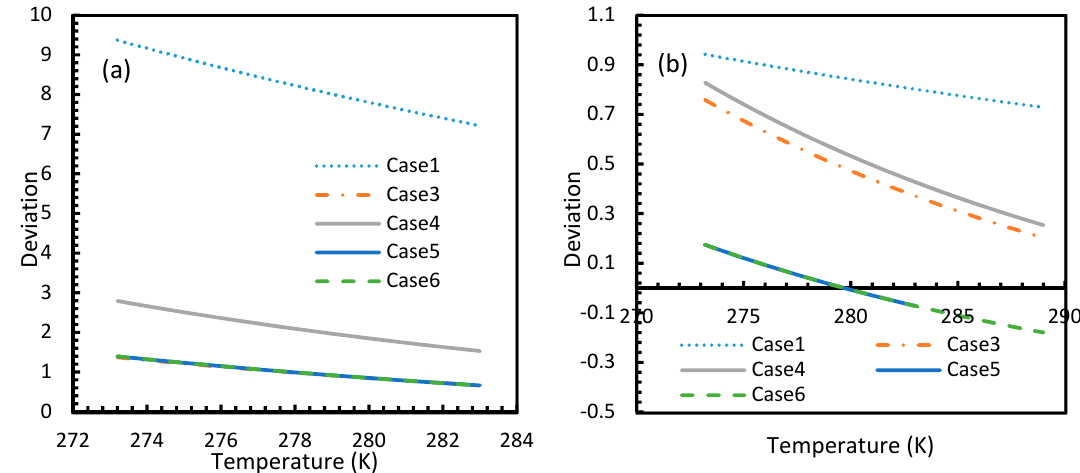
Figure 6. Profiles of deviations of dissolved CO 2 ( a ) and CH 4 ( b ) concentrations in aqueous phase calculated under the considered cases from the reference case (Case 2). The depletion in deviations is observed at high operational temperatures. One can see the deviations are considerably high with CO 2 as the guest gas, compared to CH 4 .